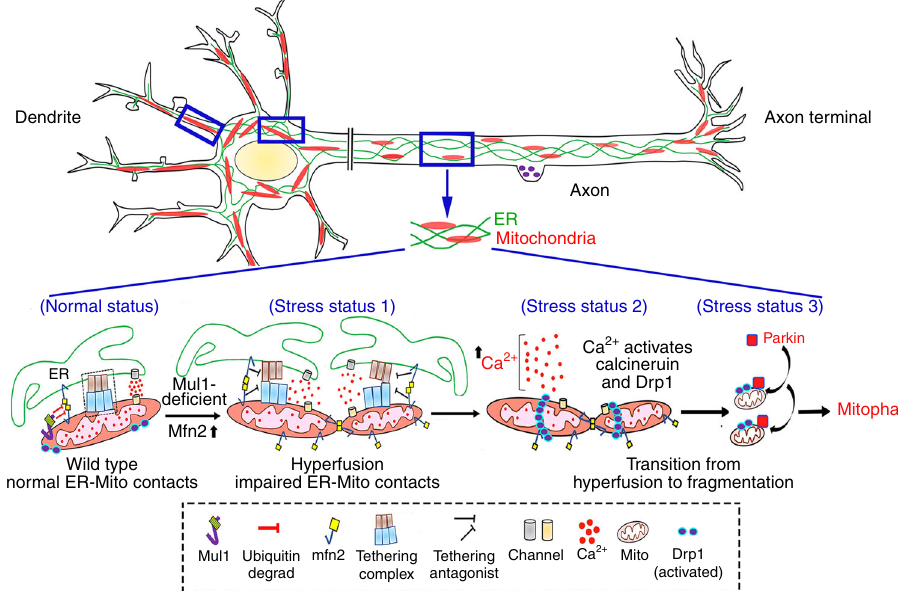
Fig. 10 Mul1 – Mfn2 pathway in the maintenance of mitochondrial morphology and ER-Mito contacts. Mul1 acts as a mitochondrial E3 ubiquitin ligase that binds and ubiquitinates Mfn2, leading to Mfn2 degradation, thus maintaining mitochondrial morphology (normal status). Mul1 de fi ciency results in the fi rst phasic mitochondrial hyperfusion by increasing Mfn2 activity (stress status 1). Increased Mfn2 activity parallelly acts as an ER-Mito tethering